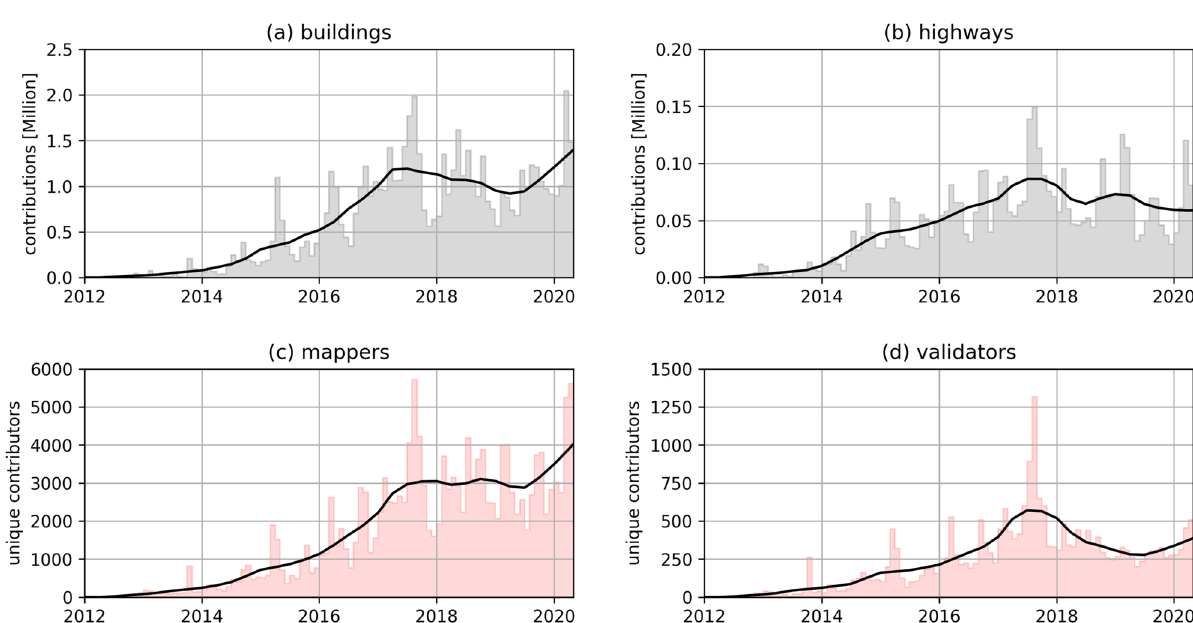
Figure 4. Distribution of GLM residuals for the number of buildings and highways added to OSM between 2008/01/01 and 2020/05/20 in regard to humanitarian mapping activities. The residuals have been derived for the subnational units and have been aggregated to the national level in a subsequent step. This plot depicts the values for all countries with medium and low human development (SHDI<0.7). Countries mentioned in the text are highlighted by increased font size. Created using Matplotlib 3.3. in Python 3.7.5 (https ://www.pytho n.org/).